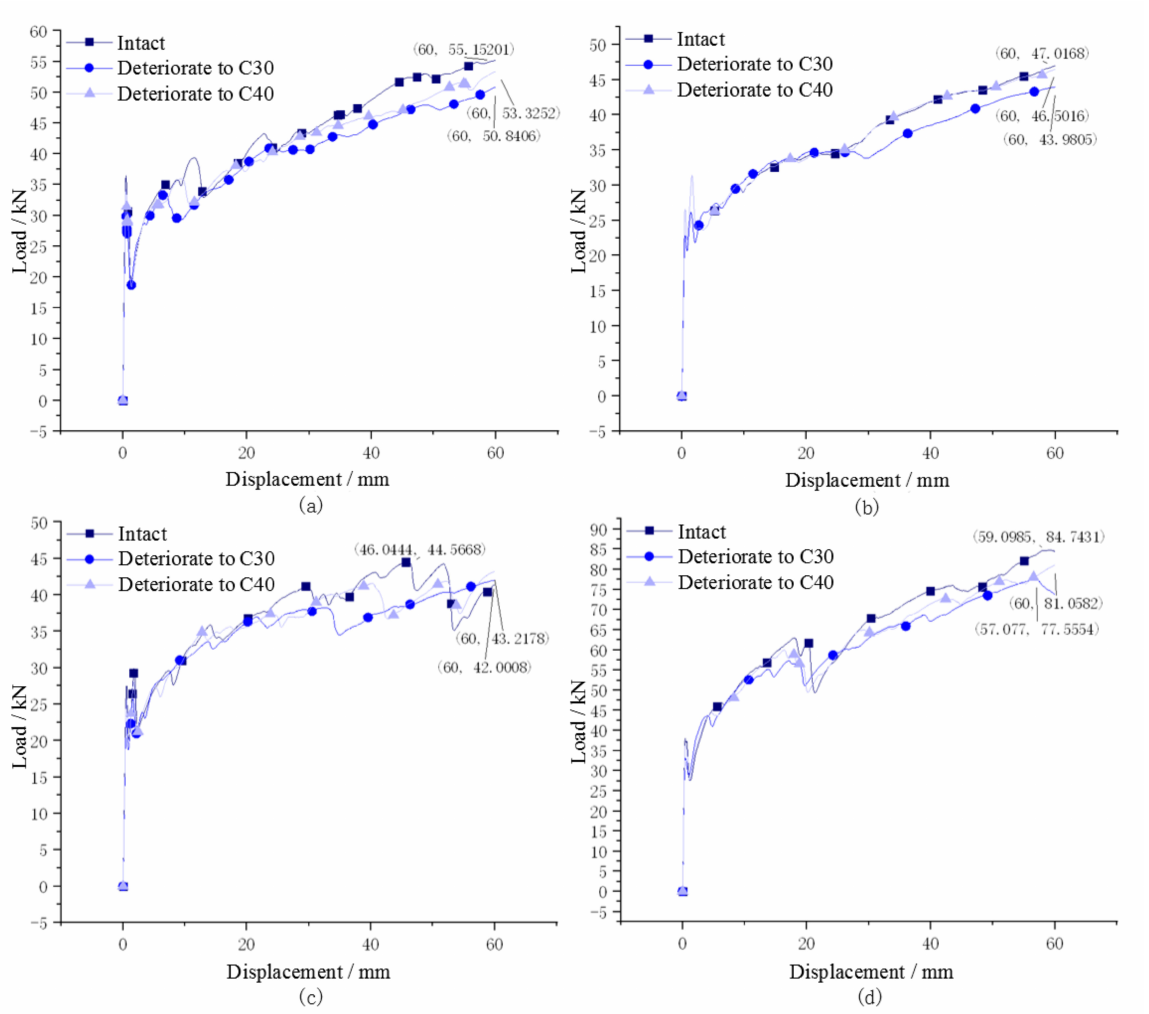
Figure 11. Effect of degree of deterioration on ( a ) circular; ( b ) rectangular; ( c ) arched; and ( d ) trenched cable